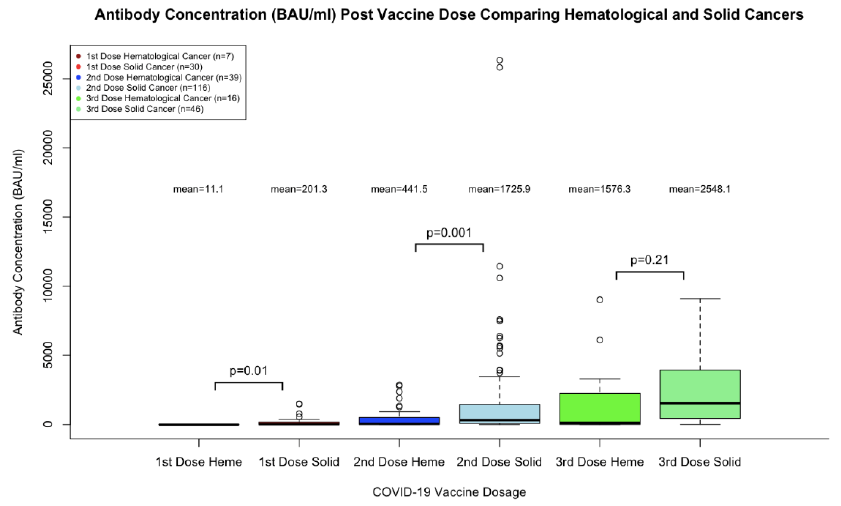
Figure 4. Comparison of Hematological and Solid Cancer Types on Antibody Production.